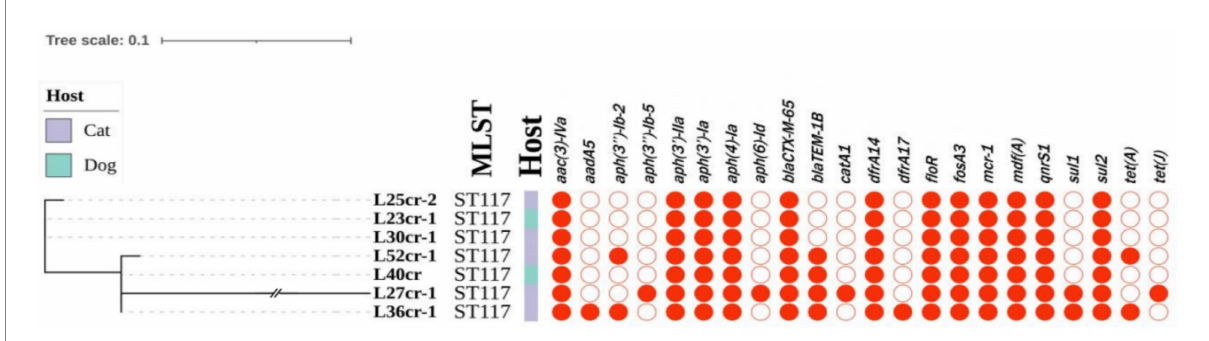
Isolate Species Source